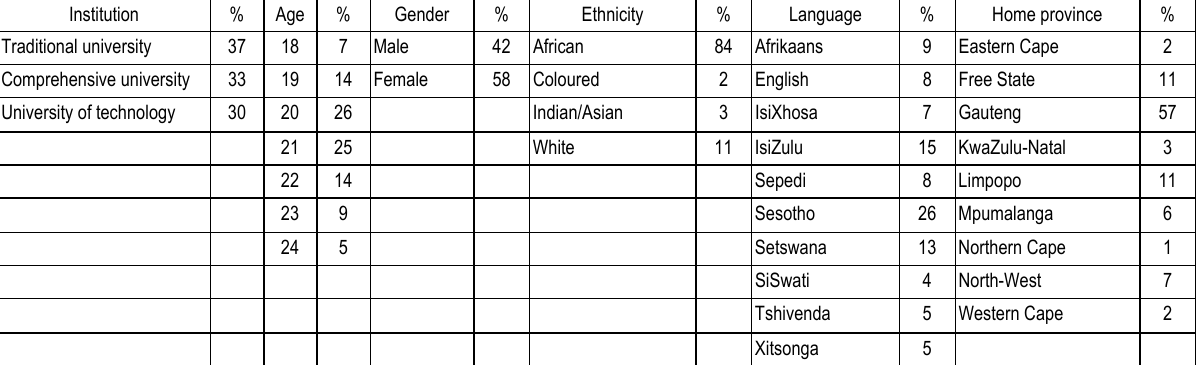
Table 1. Sample description